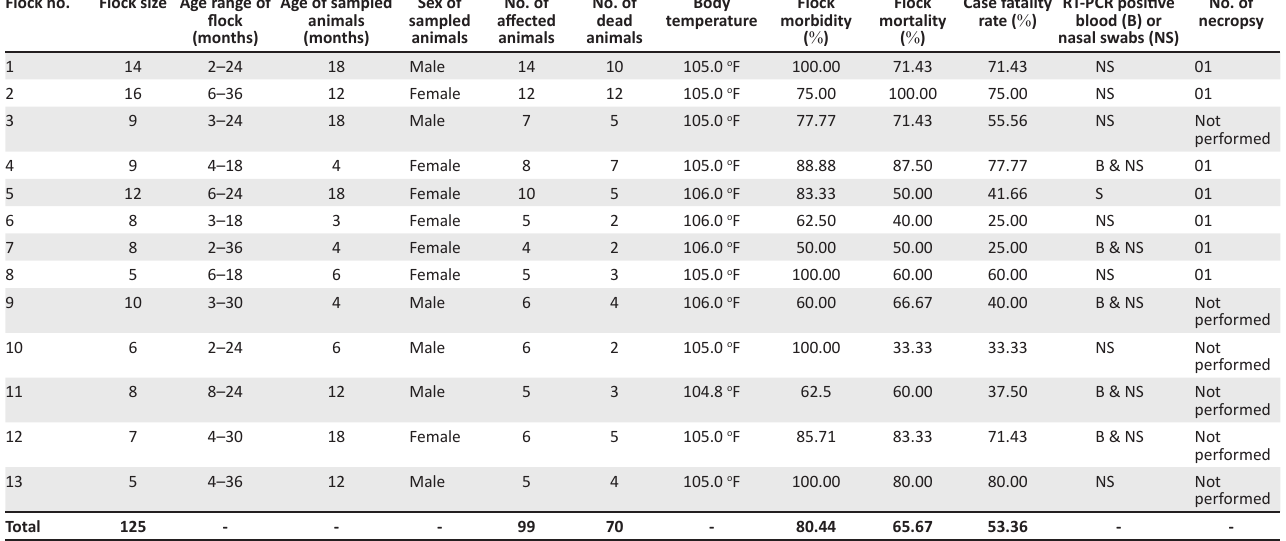
TABLE 1: Morbidity and mortality of Black Bengal goats naturally infected with peste des petits ruminants virus. Flock